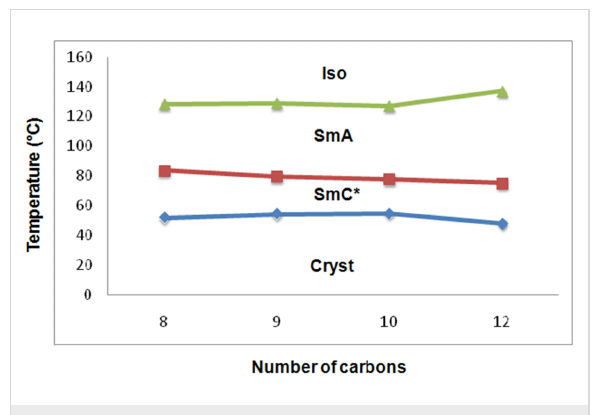
Figure 6: Phase diagram of the 13b (C 12 .Ox.C*C n )